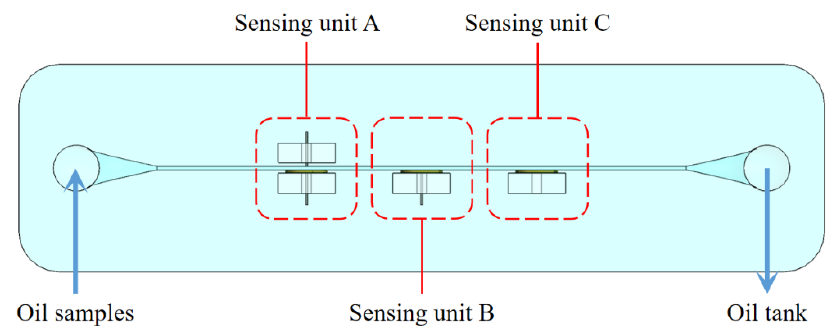
Figure 6. The sensor used for comparison experiments.